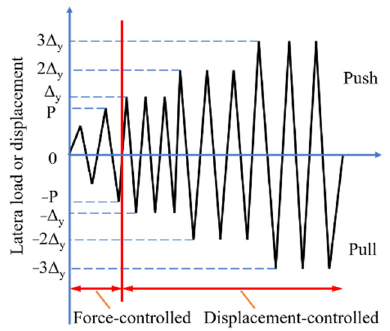
Figure 4. Cyclic lateral loading procedure.